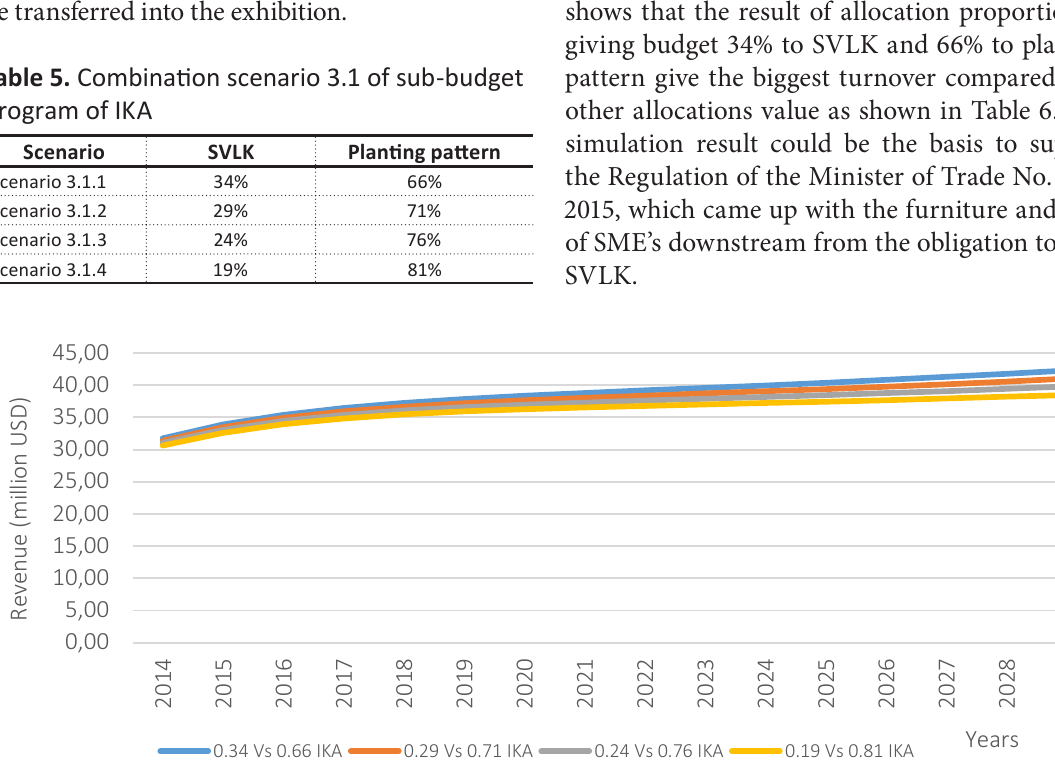
Figure 5. Simulation result from scenario